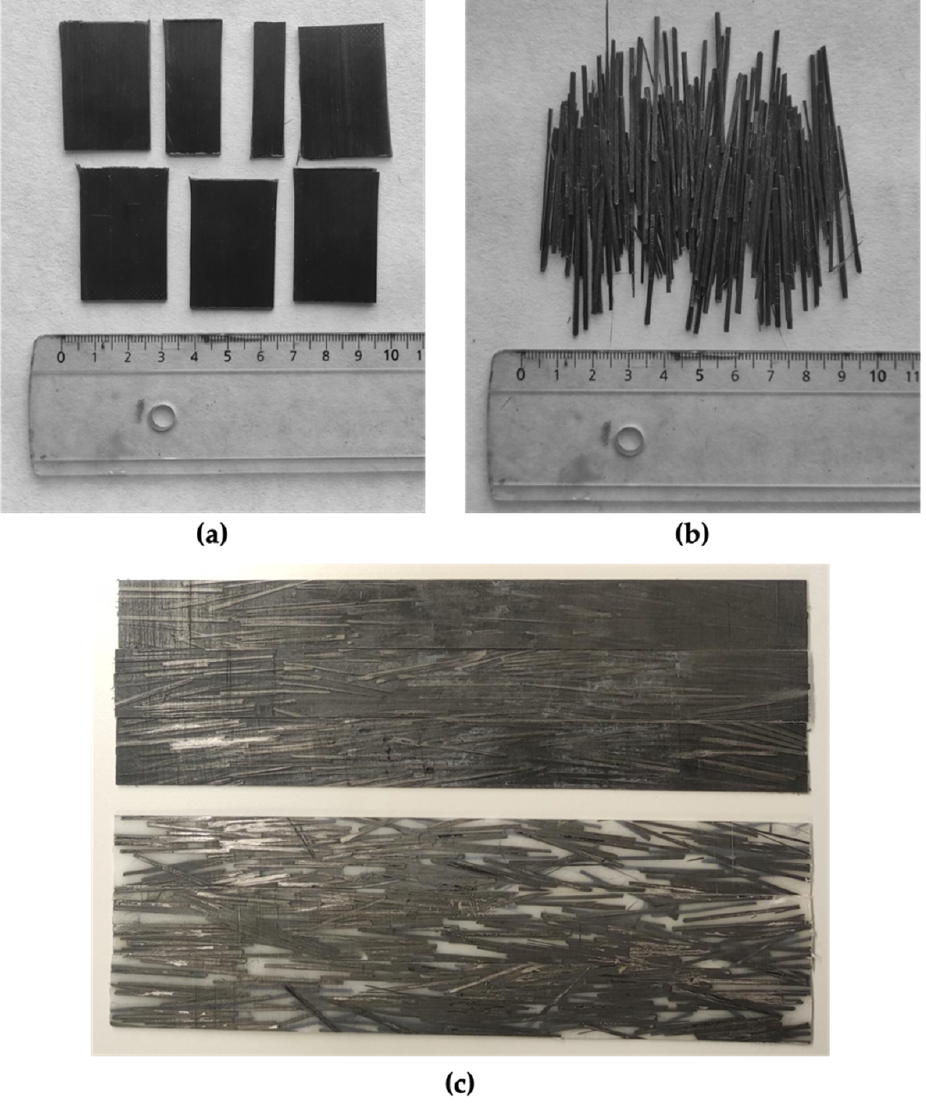
Figure 1. ( a ) Carbodur S512 before cutting. ( b ) Carbodur S512 after cutting. ( c ) Manufactured composites: PA11 ( top ) and PA12 ( bottom ).